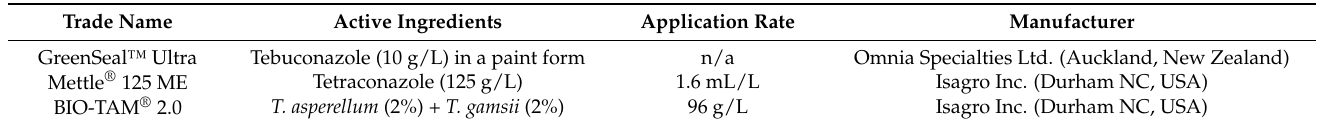
Table 2. Commercial treatments, active ingredients and manufacturers of products evaluated